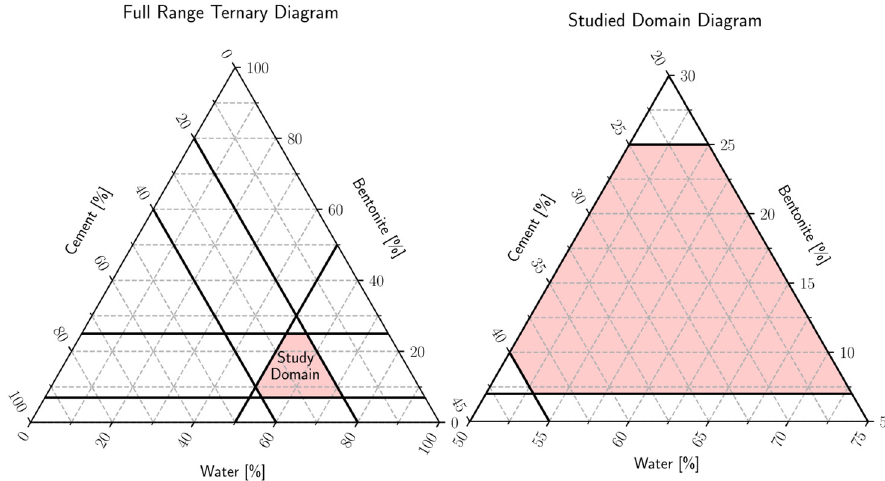
Figure 2. Ternary subdomain cropping.